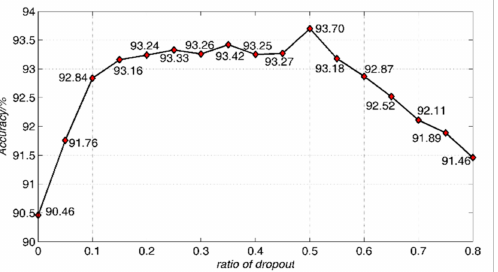
Figure 11. Some classification results in different dropout discard rates for the Qionglai ceramics.